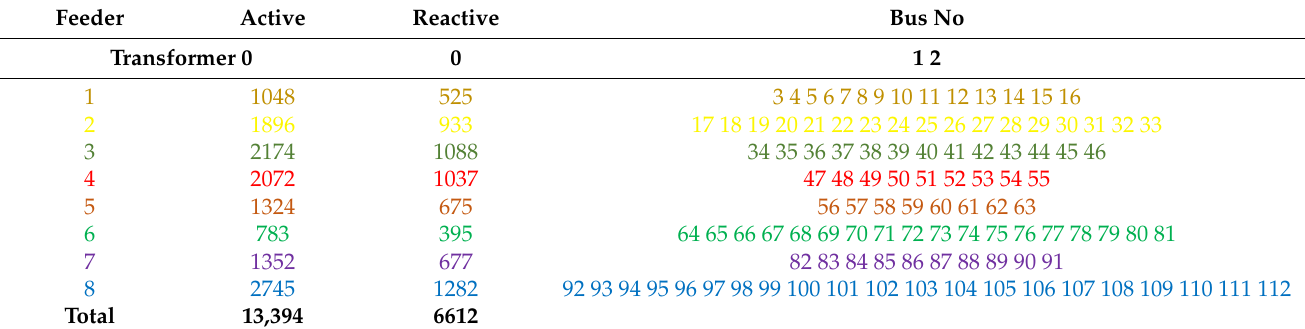
Table 1. Network load characteristics among the 8